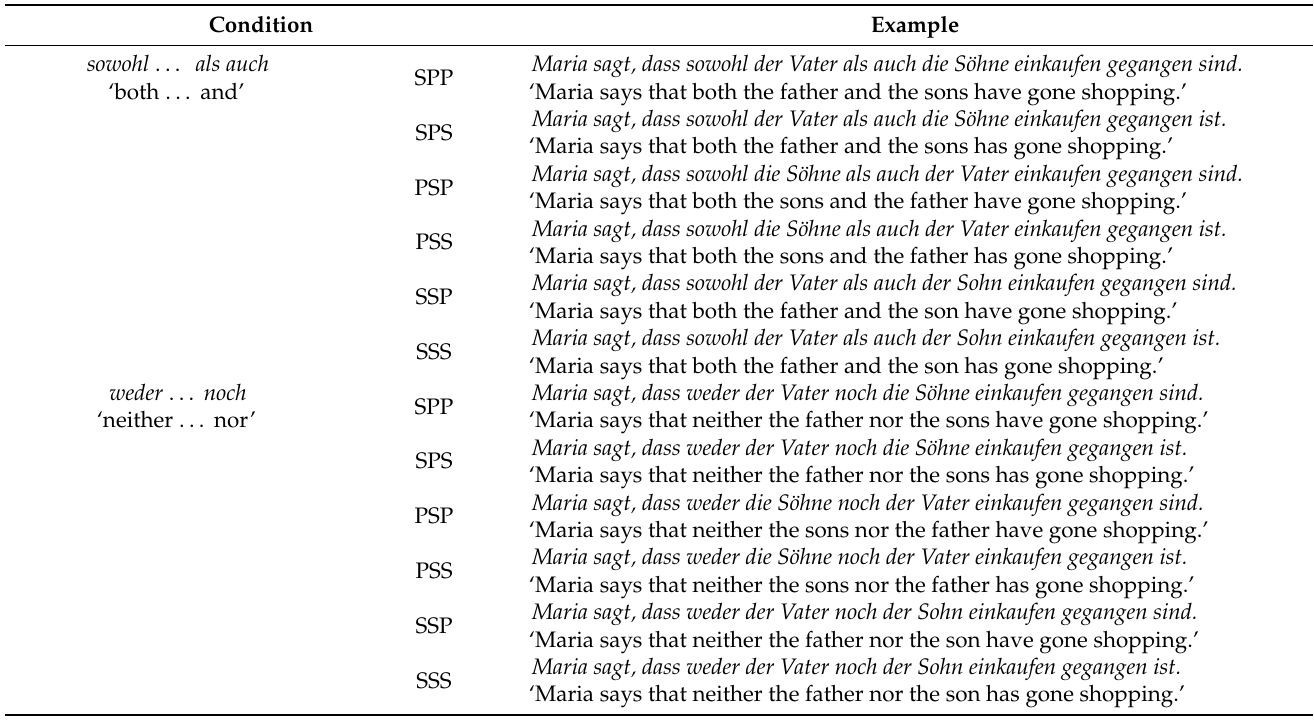
Table 1. Example stimulus set, Experiment 1 (S = singular, P = plural). Condition Example sowohl . . . als